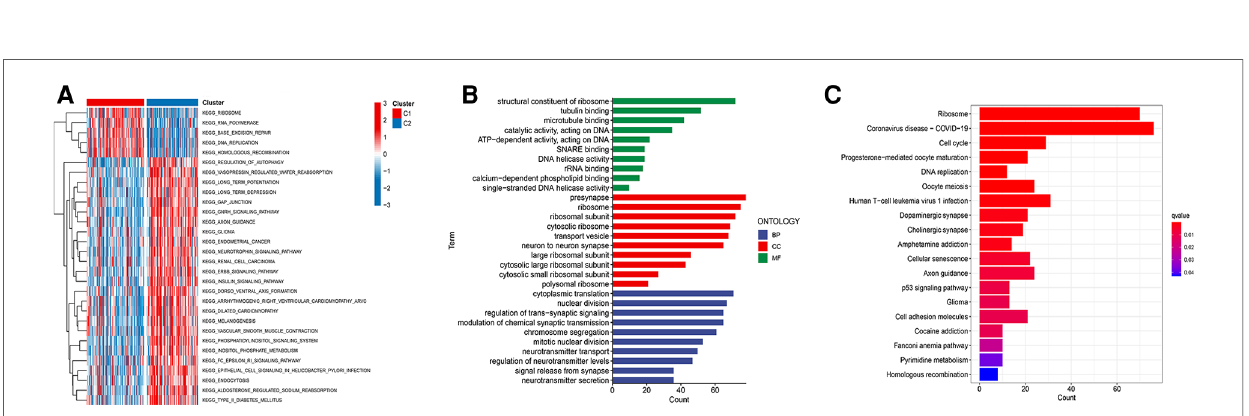
FIGURE 3 Functional enrichment analysis. ( A ) GSVA analysis of two ferroptosis subtypes in relatively activated hallmark gene sets. ( B ) Functional annotation of subtype-related DEGs by GO. ( C ) Functional annotation of subtype-related DEGs by